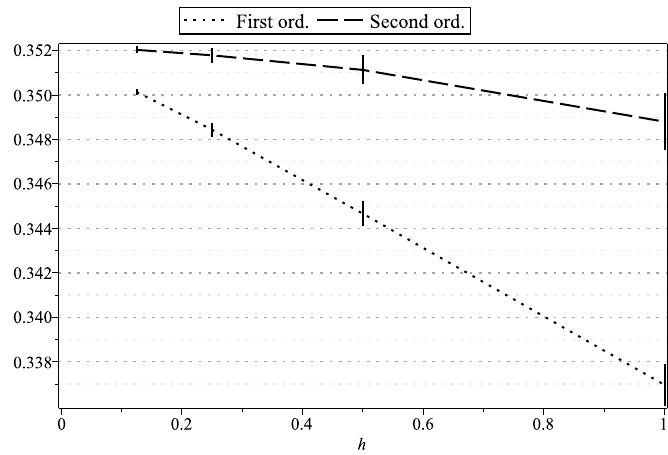
Figure 16. E e − ( 3/4 ˆ X x 1 ) as functions of h : σ = 2.0, θ = 0.04, β = 0.1, x 0 = 0.3.